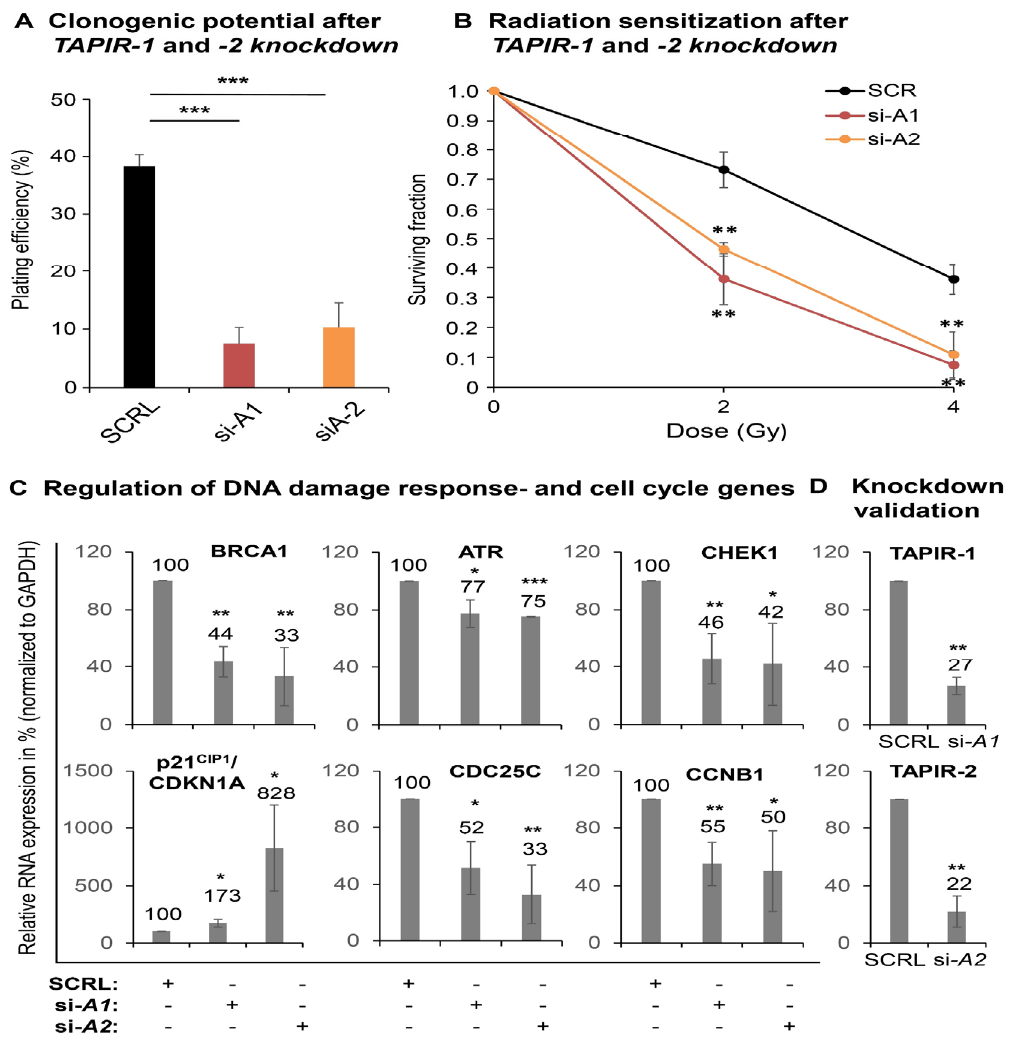
Figure 7. TAPIR knockdowns in radiation-resistant prostate cancer cells (LNCaP-RR) results in a renewed sensitization to X-ray treatment. The radioresistant LNCaP cell subline was used to analyze the effect of TAPIR knockdown on proliferation (colony formation assay) after X-ray treatment. Cells were treated with siRNA targeting TAPIR-1 or TAPIR-2 and, after plating, exposed to increasing doses of X-ray. After 10 d, surviving clonogenic cells were analyzed by counting cells that were able to form a cell clone or rather a colony. The TAPIR knockdown significantly reduces the plating efficiency and proliferation of the cells ( A ). TAPIR-1 and -2 knockdown leads to a significantly increased sensitization to radiation ( B ). The knockdown of TAPIR-1 and -2 leads to a dysregulation of DNA damage response key regulators in LNCaP-RR and to a DNA damage independent activation of the p53-DREAM signaling pathway, measured using qRT-PCR ( C ). The knockdown was validated using qRT-PCR ( D ). Data are shown as means ± s.d. n = 3, significance to control (SCRL): p ≤ 0.05 (*), p ≤ 0.01 (**), p ≤ 0.001 (***); two-sided student-t test.